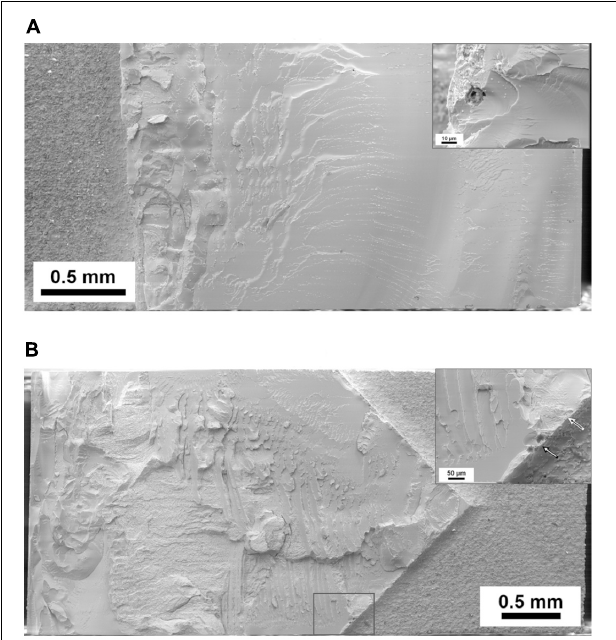
FIGURE 14 | (A) Scanning electron microscopy (SEM) image of a fracture surface of straight-through edge notched Vit 105 three-point-bending (3PB) specimen after stress corrosion cracking (SCC) test in Figure 13 , inset: site of pitting and most plausible crack initiation and (B) SEM image of a fracture surface of a chevron-notched Vit 105 3PB specimen which failed upon SCC testing at open-circuit potential (OCP) condition, inset and lower box: pitting and possible crack